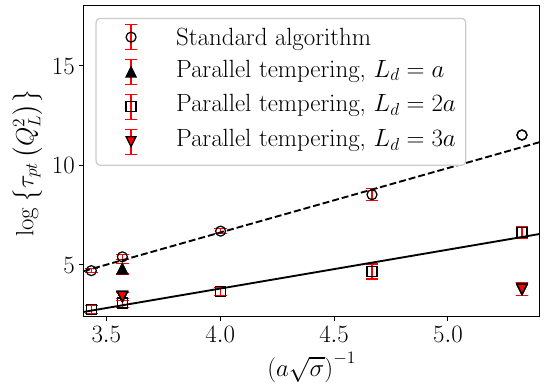
Figure 4 . Scaling of τ Q 2 with the inverse lattice spacing obtained by using the local algorithms pt L or parallel tempering for N = 6. The scaling of the autocorrelation time obtained with the standard (cid:0) (cid:1) algorithm and with parallel tempering at fixed L d /a = 2 are both compatible with an exponential scaling in 1 /a (dashed and solid line). Best fits performed with the fit function log k 1 / ( a √ σ ) yield k 1 = 3 . 24(20) and 1 . 95(17) for the standard and the parallel tempering updates